Question: Give a one-sentence summary of this figure.
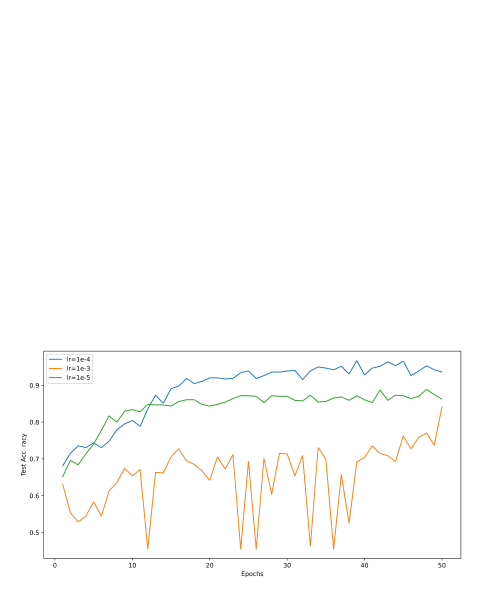
Answer: Accuracy under different learning rates.